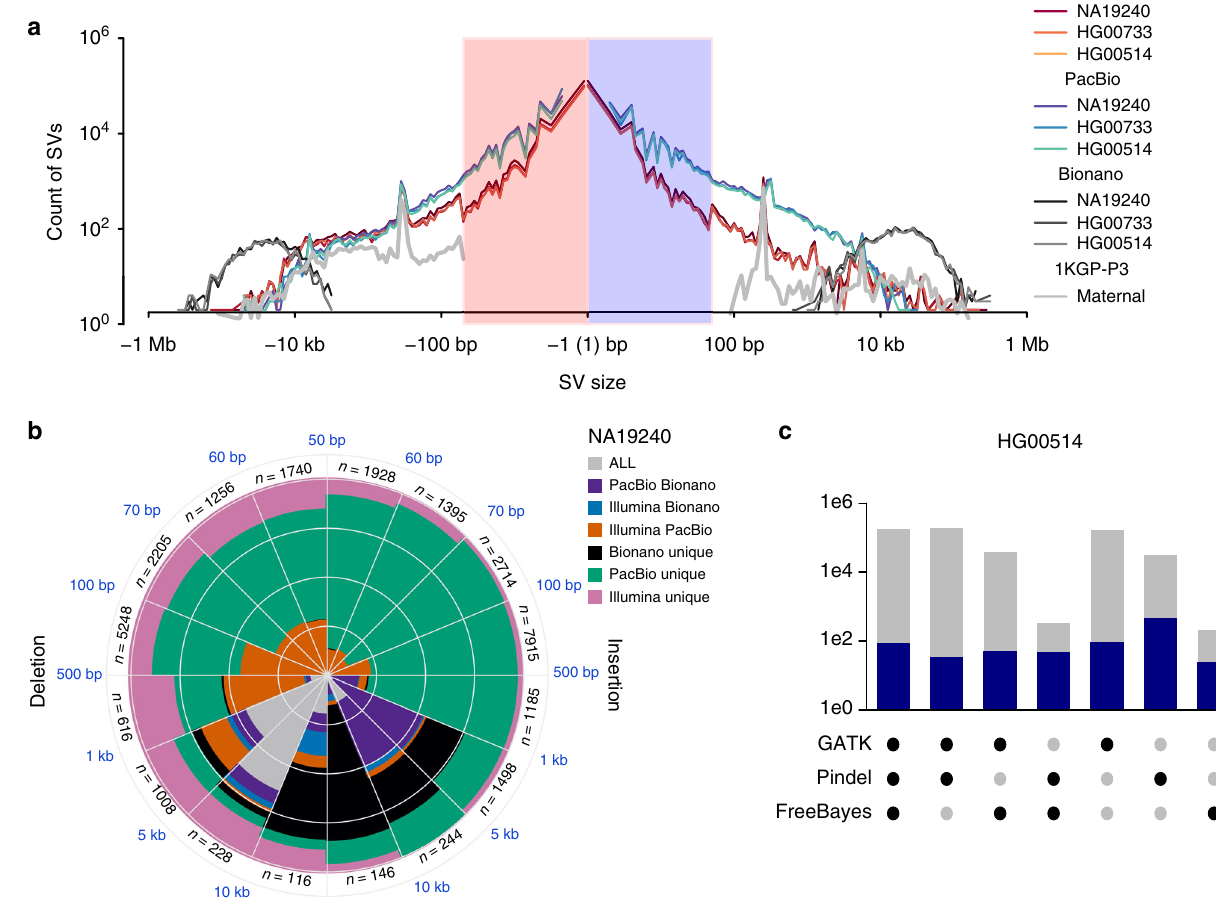
Fig. 2 Comparison and integration of indel and SV callsets on HG00733, HG00514, and NA12940. a Length distribution of deletions and insertions identi fi ed by PB (blue), IL (red) and BNG (brown), respectively, together with averaged length distribution of SVs discovered in the maternal genomes by the 1KG-P3 report (silver). b Number of SVs discovered by one or multiple genome platforms in the YRI child NA19240. c Overlap of IL indel